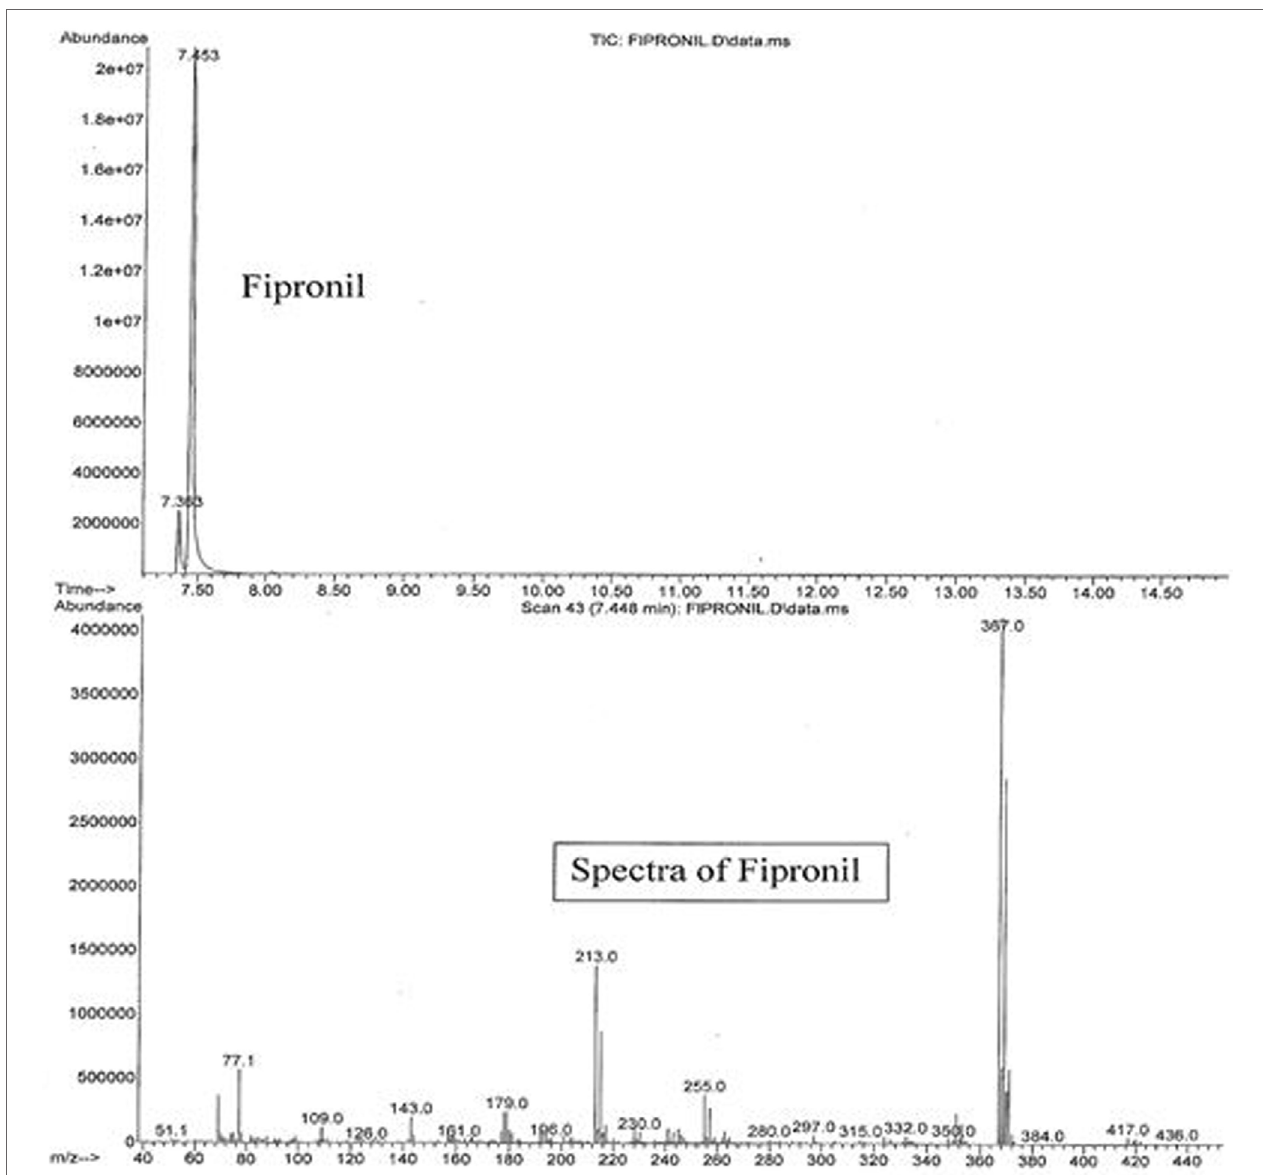
FigUre 2 | Total ion chromatogram (upper panel) and ion spectrum (lower panel) of fipronil